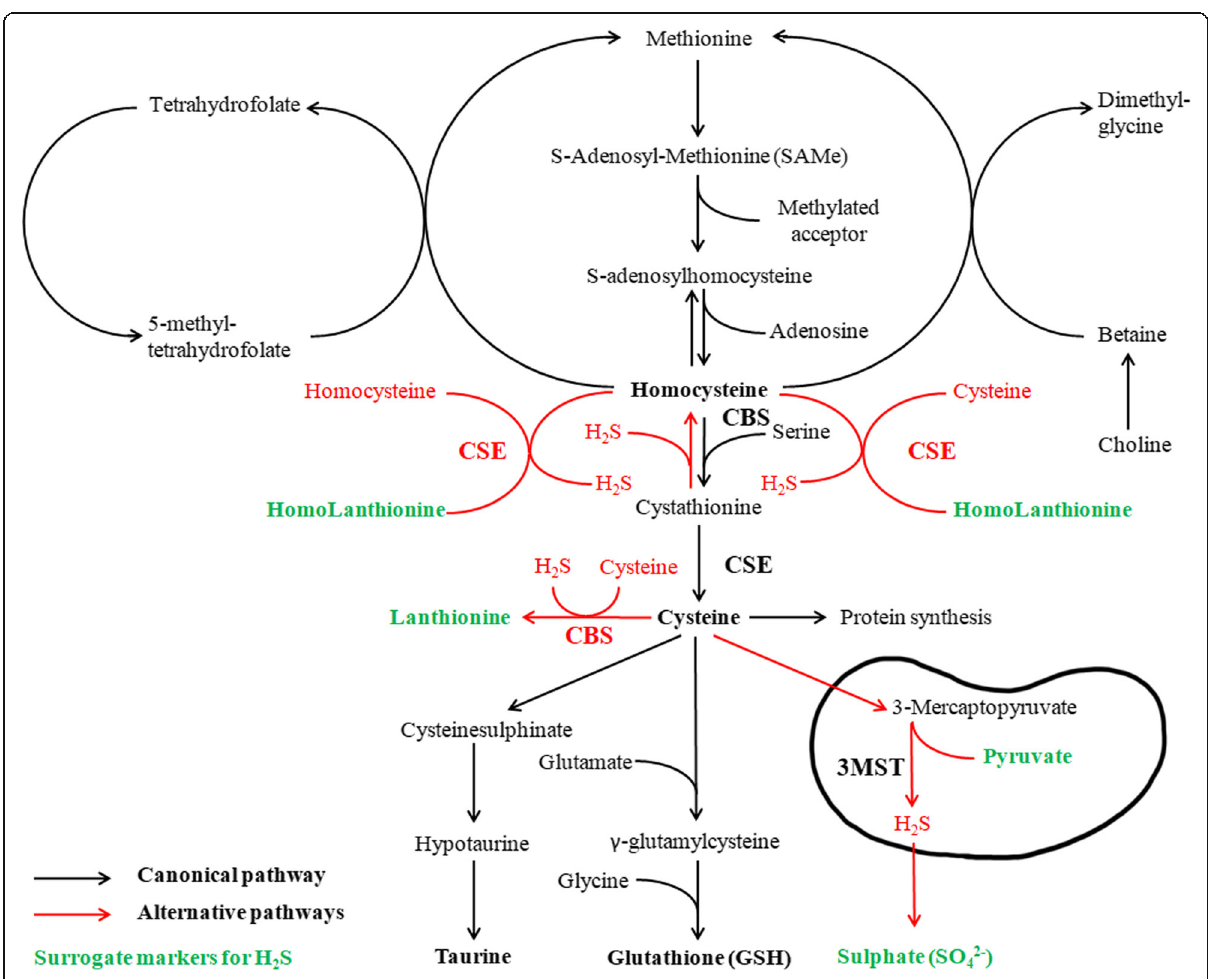
Fig. 1 Canonical and alternative transsulfuration pathways. The canonical pathway, i.e. transulfuration of homocysteine to cysteine and then GSH synthesis, are shown by black lines; alternative pathways, leading to H 2 S release, are shown by red lines. The products of H 2 S releasing reactions, functioning as surrogate markers of H 2 S release are shown in green colour: Lanthionine reports on H 2 S from CBS reactions; Homolanthionine reports on H 2 S from CSE reactions; Pyruvate reports on intramitochondrial release by 3MST; Sulphates (SO42-) reports on H 2 S oxidation on the respiratory